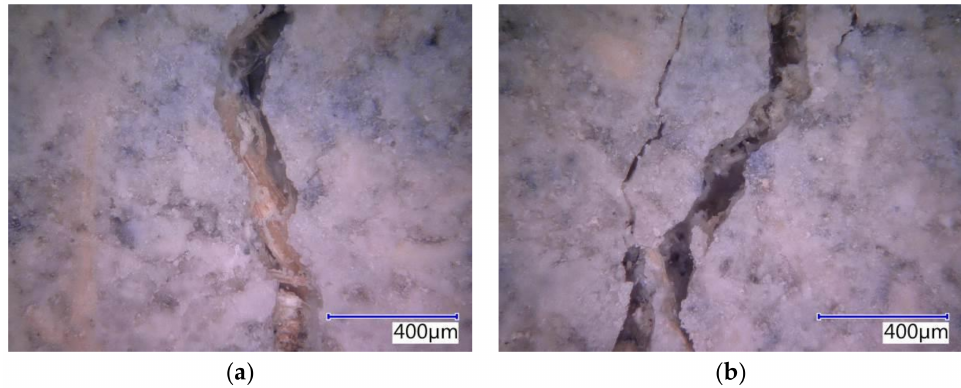
Figure 27. The detailed structure of crack in Du-M20—pictures from optical microscope: ( a ) deteri- orated chip partially pulled out from the matrix; ( b ) deteriorated locality with probable cluster of dust DU.